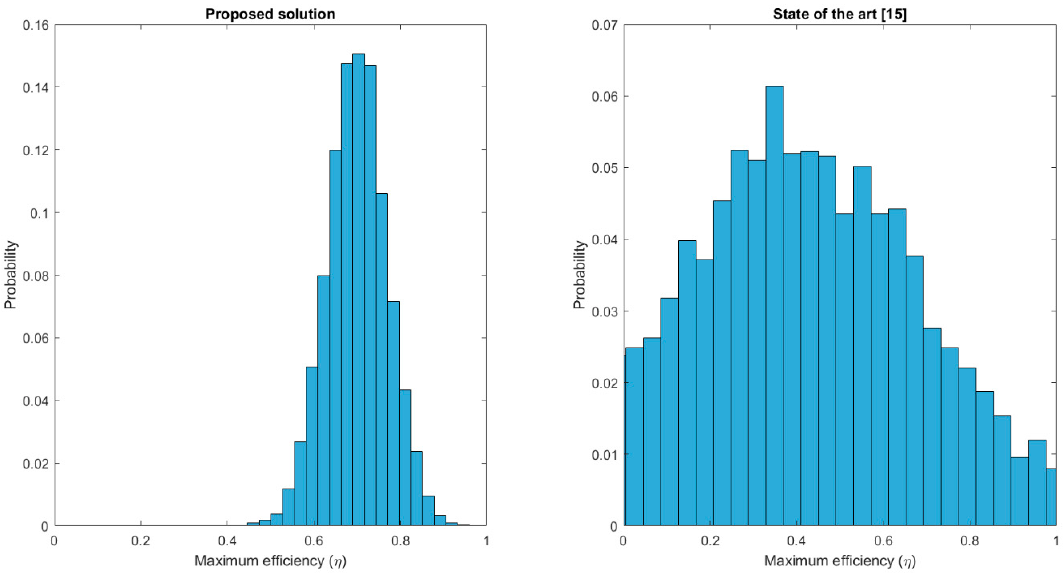
Figure 10. Third experiment: results.